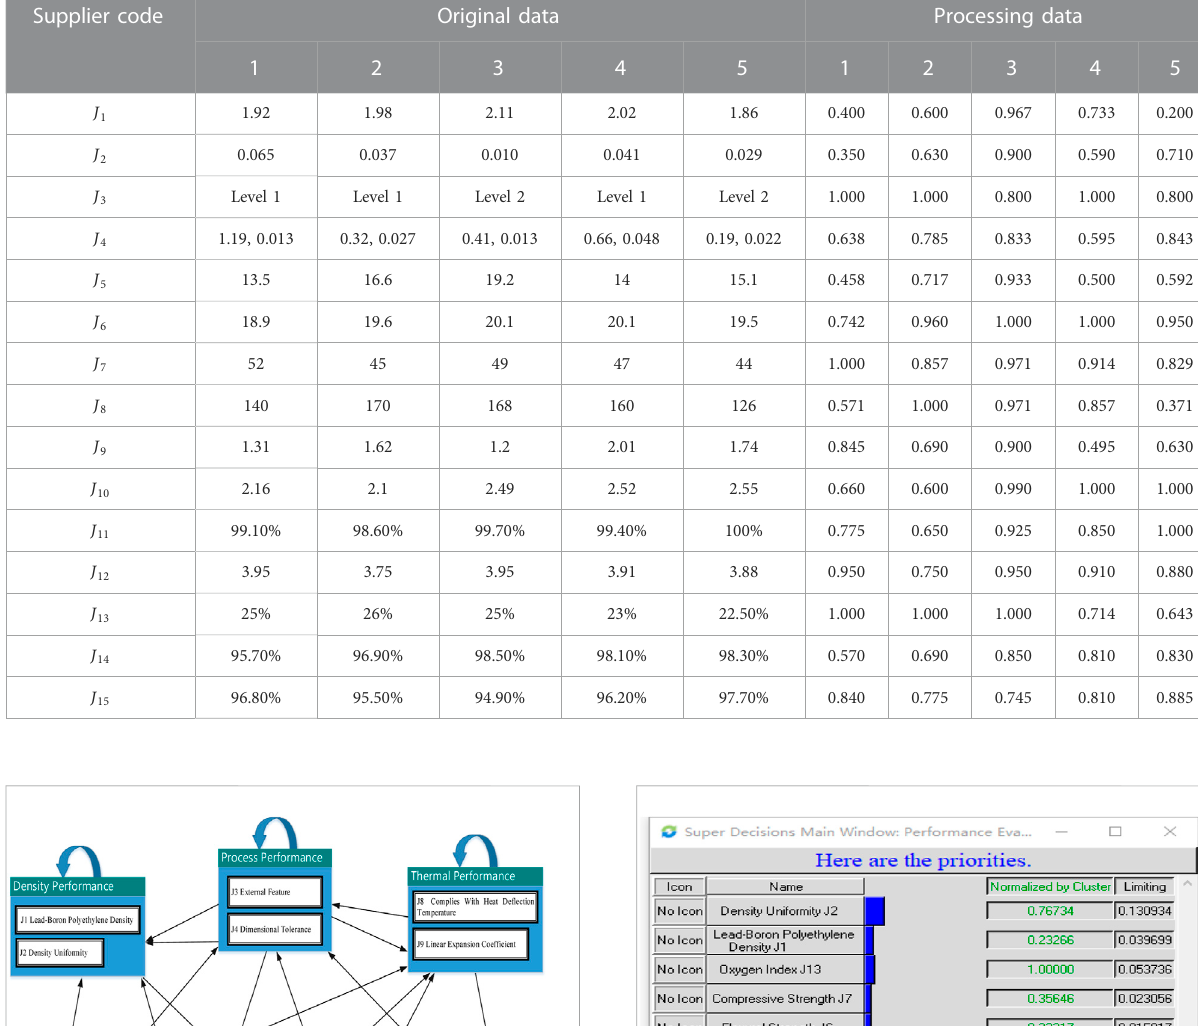
TABLE 3 Data collection and processing of lead-boron polyethylene composite shielding material products provided by fi ve suppliers.